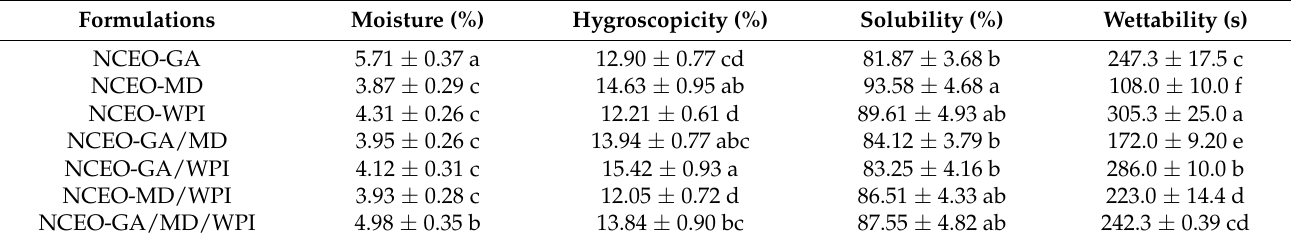
Table 4. Moisture, hygroscopicity, solubility, and wettability of CEO